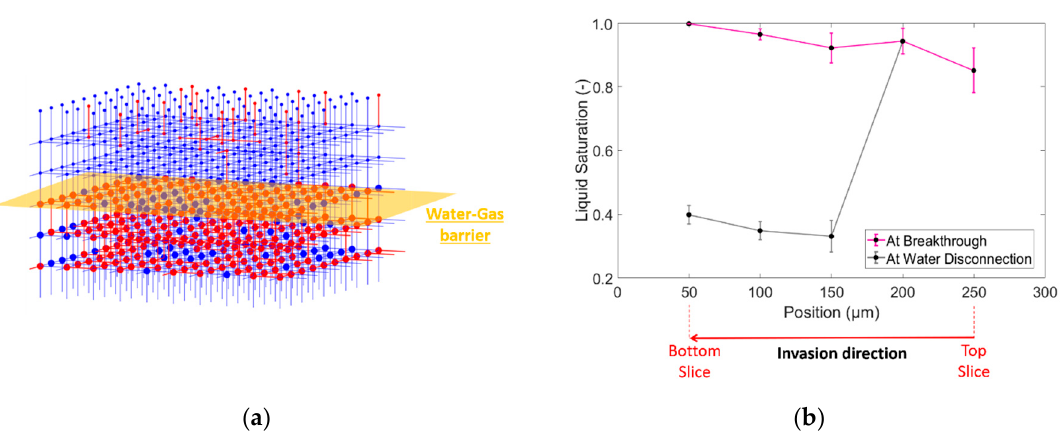
Figure 14: ( a ) Phase patterns and ( b ) saturation profiles of a 3D pore network with dual porosity (similar as in Figure 2).